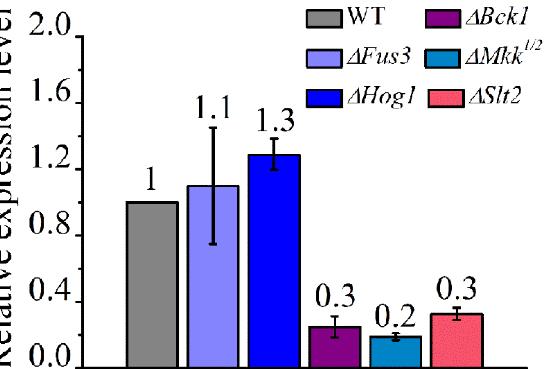
Figure 4. qRT-PCR analysis of the expression of the gene Rns1 during conidiation in the WT strain, the deletion mutant ∆ Fus3 (Fus3-MAPK), ∆ Hog1 (Hog1-MAPK) and the three deletion mutants in the Slt2-MAPK cascade: ∆ Bck1 (MAPKKK), ∆ Mkk 1/2 (MAPKK) and ∆ Slt2 (MAPK). The values rep-